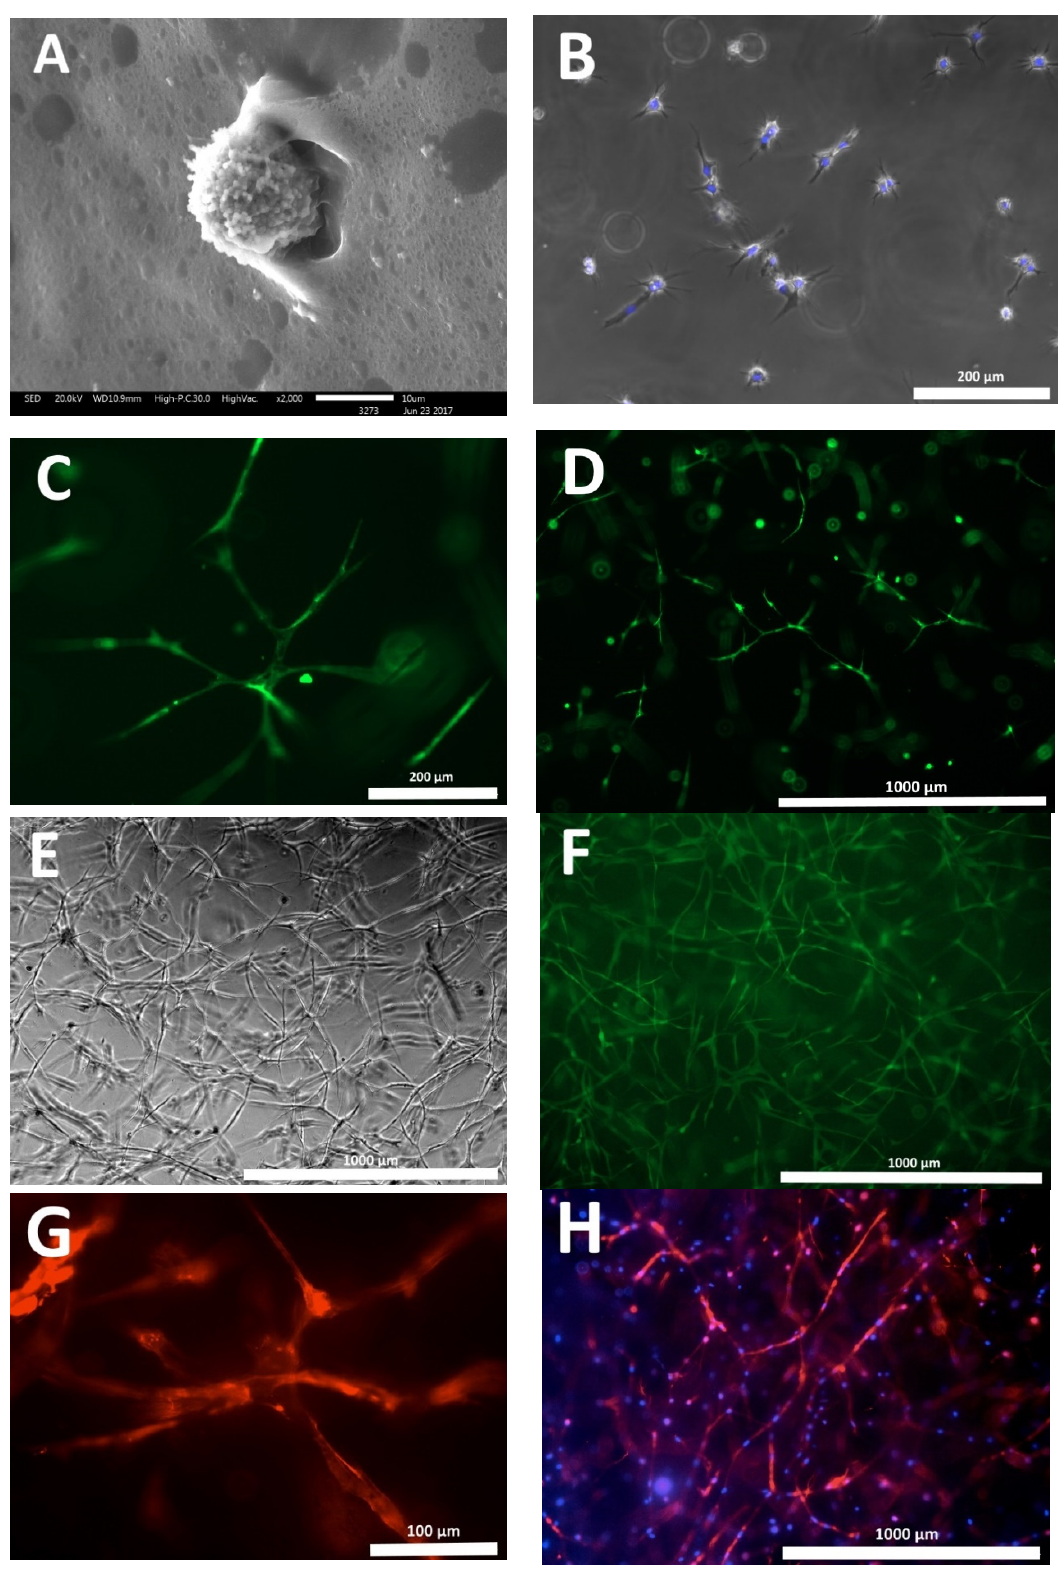
Figure 2. Cultivation of scaffolds with encapsulated ASCs. ( A ) ASCs adhered within the scaffold structure, after 24 h of cultivation, scanning electronic microscopy; ( B ) ASCs in the scaffold structure after 48 h of cultivation, here the cells have formed multiple processes. Phase-contrast combined with fluorescence microscopy, cell nuclei stained with Hoechst 3334—blue, ( C , D ) ASCs in the scaffold structure—third day of cultivation, cells exhibit three-dimensional growth and form intercellular